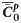
Average outflow facility C¯0p as a function of intraocular pressure and for a range of values of α.These average facility curves are calculated using Eq (26), but wrongly assumes pT is equal to zero, when in fact pT equals 3 mm Hg.